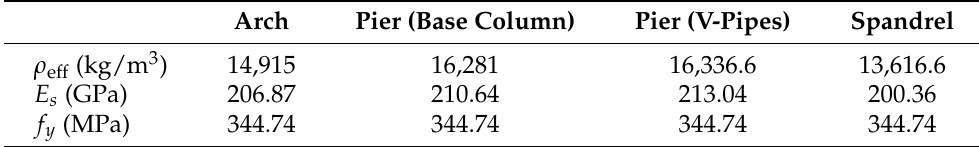
Table 6. Steel properties [36].